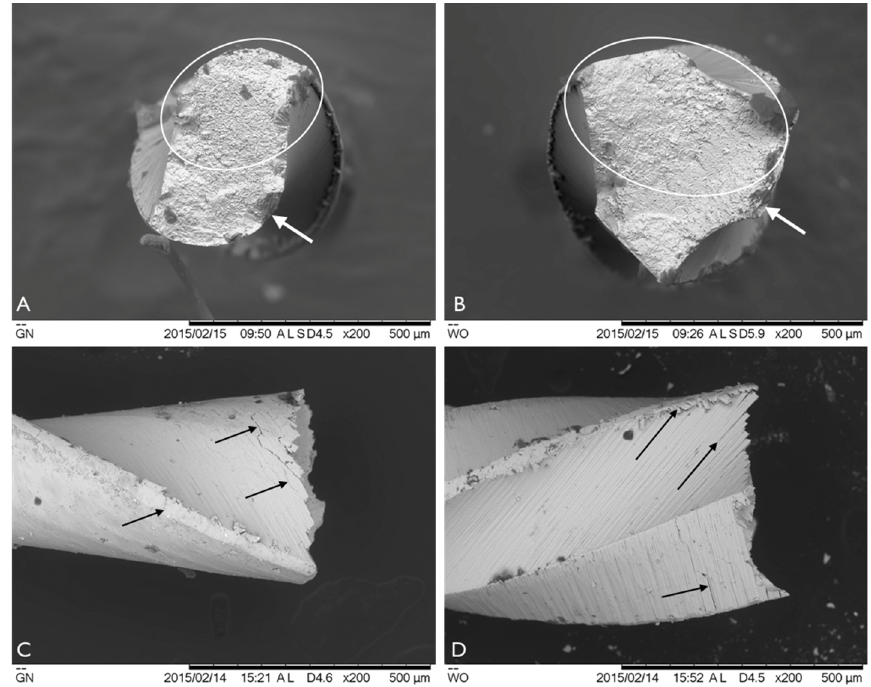
Figure 5. SEM micrographs of the fractured cross-sectional and side surfaces of separated fragments of GN ( A , C ) and WO ( B , D ) files after cyclic fatigue test. Microbubbles, craters, irregularities and dimples represent typical topographic characteristics of the fracture surface ( A , B ). Crack initiation (white arrows) and overload fast fracture zones (white oval) on the surfaces. Side view of the alterations in instruments after testing (black arrows): blunt or disrupted edges, cracks along mechanical grooves on the instrument surface.